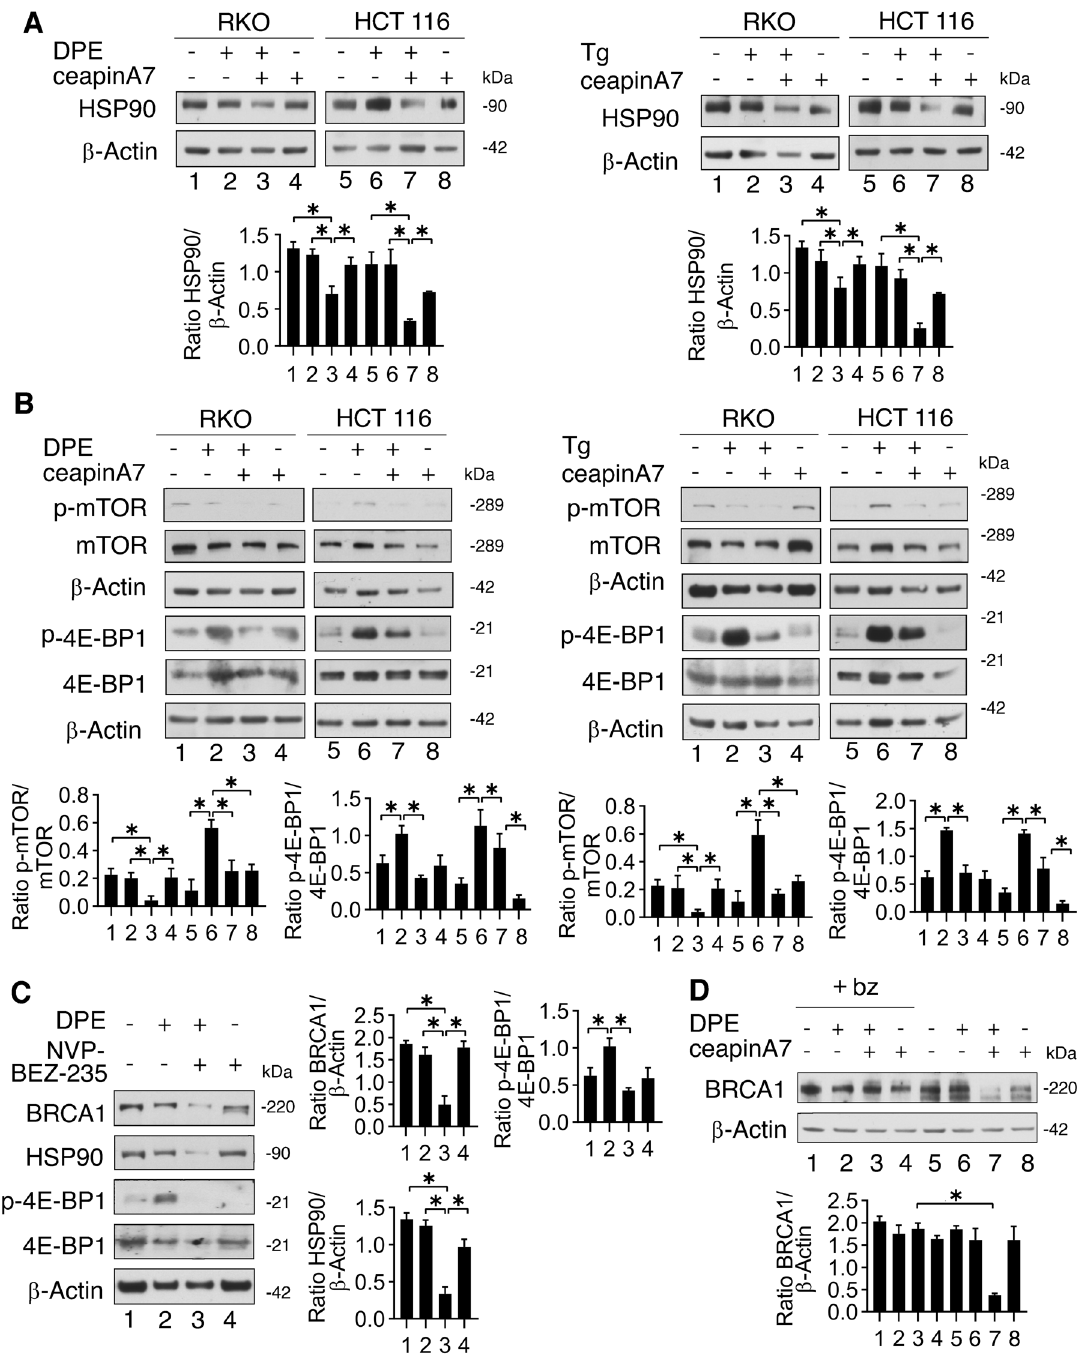
Fig. 5 ATF6 sustains mTOR activation and HSP90 expression during ER stress which stabilizes BRCA-1 and prevents its proteasomal degradation. RKO and HCT116 cells were pre-treated or not with ceapinA7 (12 μ M) for 1 h and then treated or not with DPE (100 μ M) or Thapsigargin (Tg) (30 nM) or left untreated, as control. A , B Protein expression level of HSP90, p-mTOR, mTOR, p-4EBP1, and 4EBP1 was evaluated by western blot analysis. β -Actin was used as loading control. The histograms represent the densitometric analysis of the ratio of speci fi c protein and the appropriate control of three different experiments. Data are represented as the mean plus S.D. * p -value < 0.05. C RKO cells were pre-treated or not with NVP-BEZ-235 (250 nM) for 1 h and then treated or not with DPE (100 μ M) or left untreated, as control. Protein expression level of BRCA-1, HSP90, p-4EBP1, and 4EBP1 was evaluated by western blot analysis. β -Actin was used as loading control. The histograms represent the densitometric analysis of the ratio of speci fi c protein and the appropriate control of three different experiments. Data are represented as the mean plus S.D. * p -value < 0.05. D RKO cells were pre-treated or not with ceapinA7 (12 μ M) for 1 h and then treated or not with DPE (100 μ M) for 48 h. To evaluate proteasomal degradation cells were incubated or not with Bortezomib (bz) (10 nM) for the last 4 h of treatments. Western blot analysis of BRCA-1 expression level. β -Actin was used as loading control and one representative experiment is shown. The histograms represent the densitometric analysis of the ratio of BRCA-1/ β -Actin of three different experiments. Data are represented as the mean plus S.D. p value: *< 0.05.